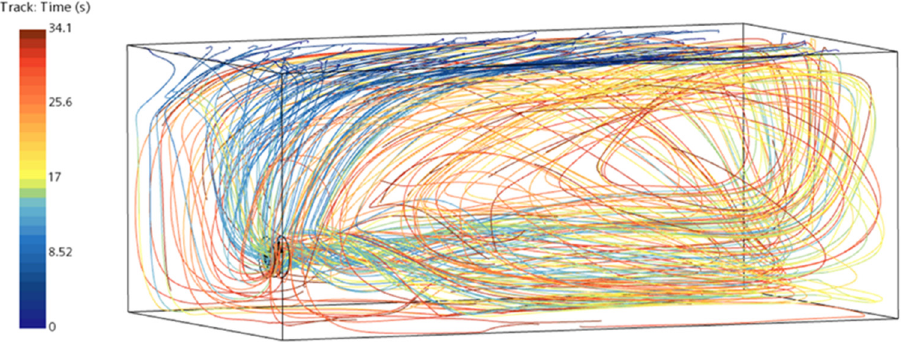
Figure 8. Particle trajectory diagram.